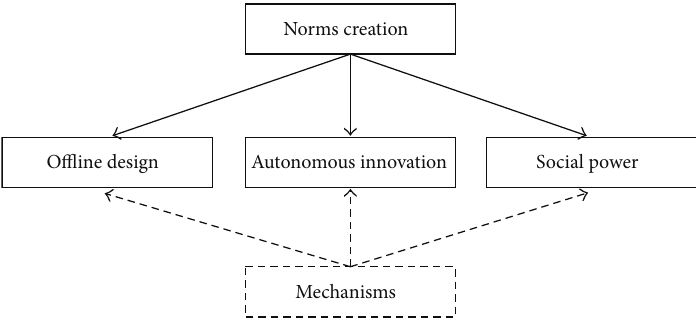
Figure 4: Norms creation